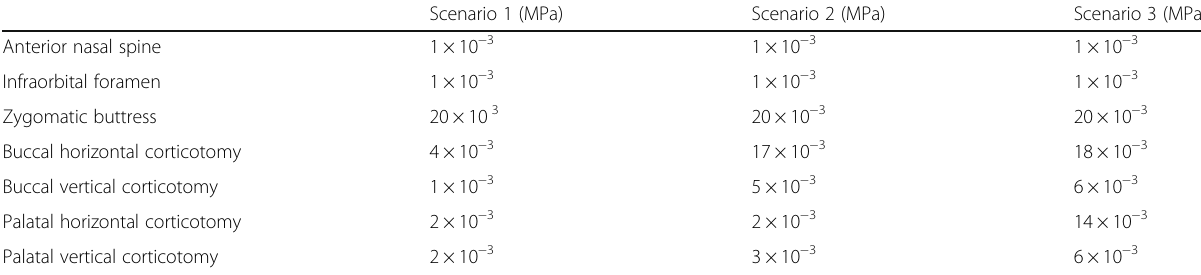
Table 3 Von Mises stress values for the cancellous bone Scenario 1 (MPa) Scenario 2 (MPa) Scenario 3